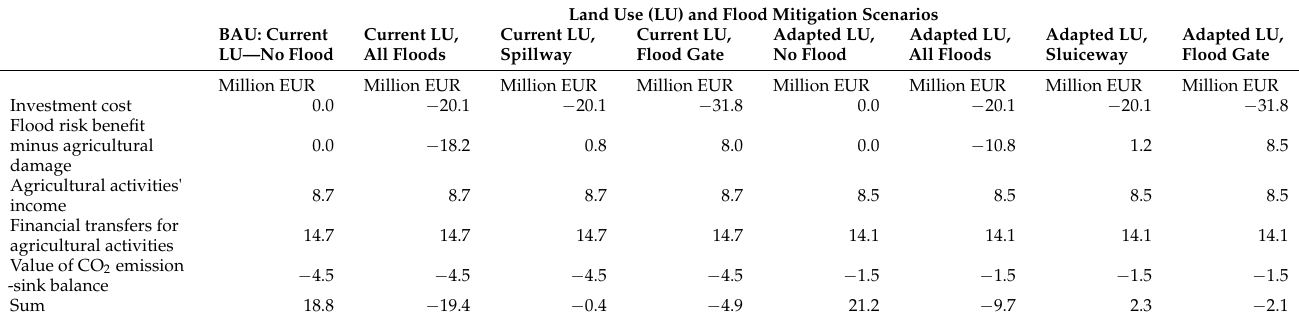
Table 5. Costs and benefits of various scenarios in the Cibakh á za-Tiszaföldv á r floodplain area. Legend: The “Flood risk benefit minus agricultural damage” row of the table shows relative results, the BAU status has an initial flood risk exposure ( − 85 million EUR) that is excluded from the “Current LU, no flood” scenario for the better comparability. Source of data: Ref. [22].